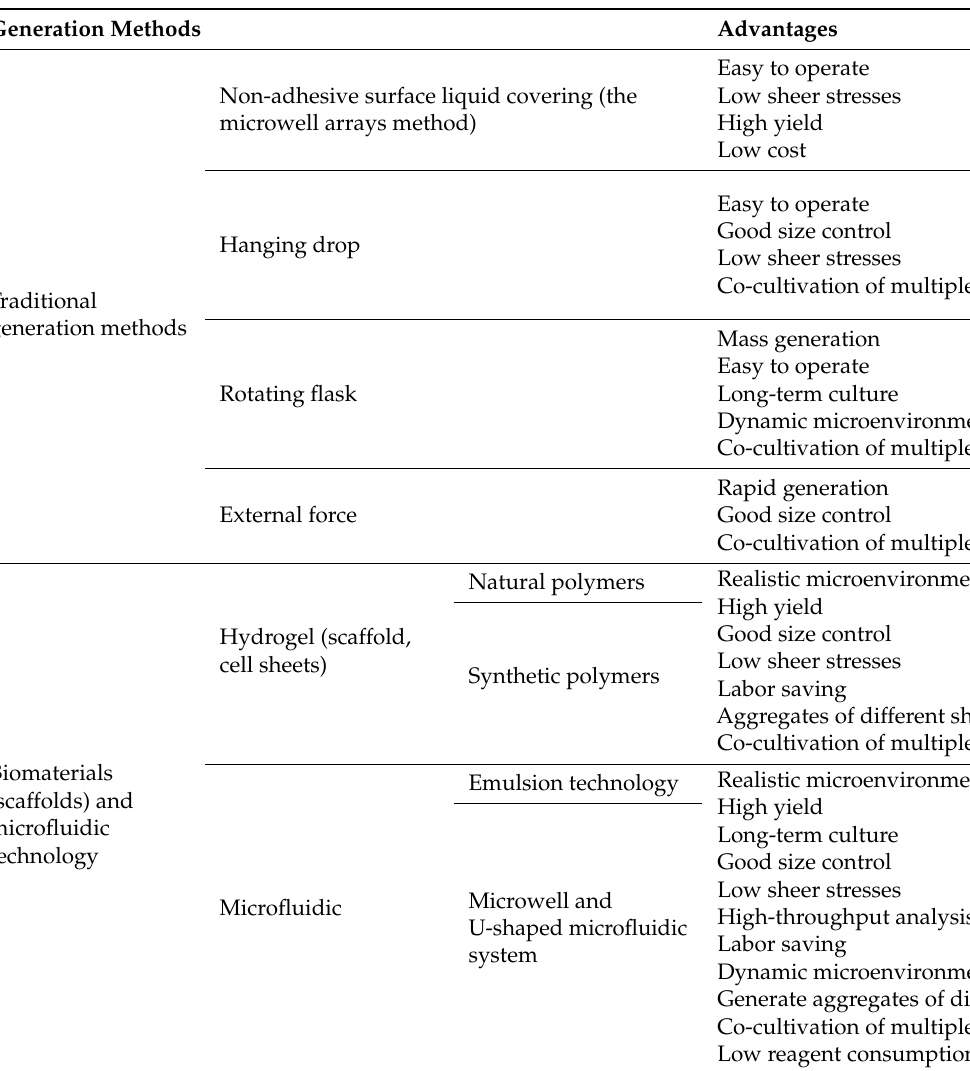
Table 1. A comparison of MCS generation